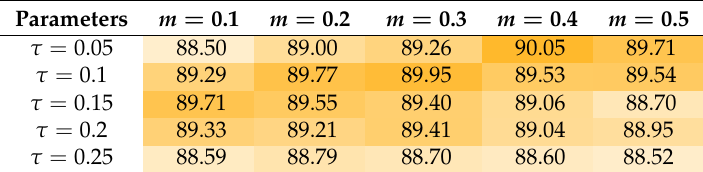
Table 6. Analysis of the τ and m parameters on the NWPU-RESISC45